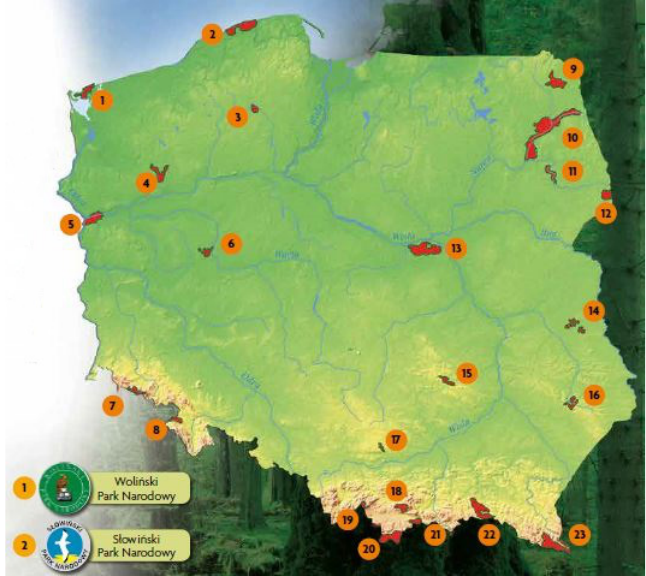
Fig. 5. The map of Poland from Nasza szkoła (reduced, source: M. Lorek, M. Zatorska,